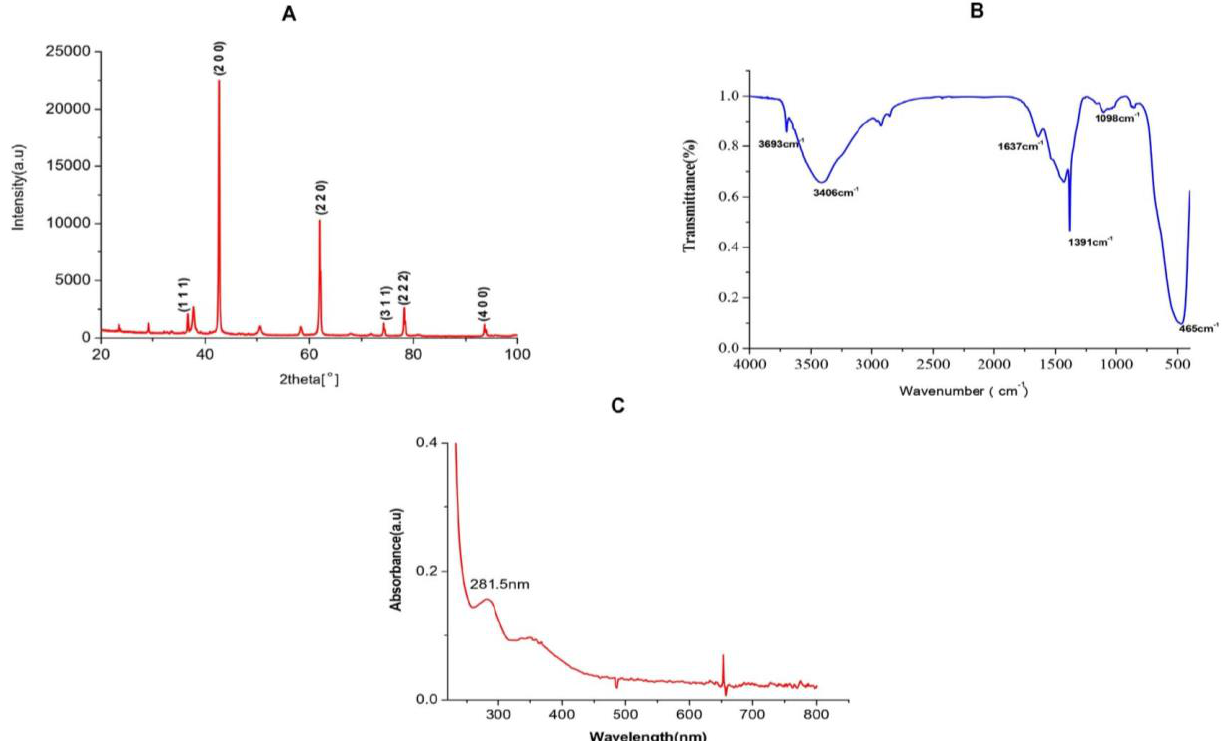
Figure 1. ( A ) XRD detector pattern of TAFEMgO NPs. The high dense peak at 2θ = 42.55° with interplanar spacing (d-spacing) 2.122 Å is due to (2 0 0) reflection of cubic MgO. ( B ) Fourier transform infrared spectroscopy (FTIR) spectrum of TAFEMgO NPs showing stretching band of synthesized TAFEMgO NPs. ( C ) UV-visible spectroscopy pattern of TAFEMgO NPs showing two reflection minima at 210 and 281 nm.